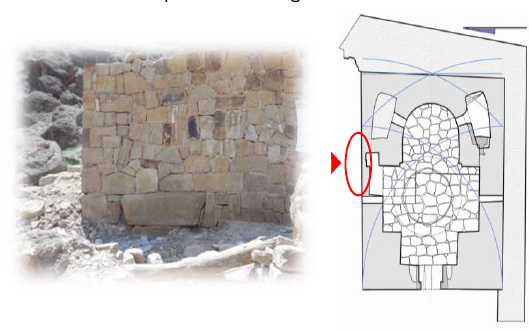
Figure 19. Overheads problems, because of previous wrong restoration